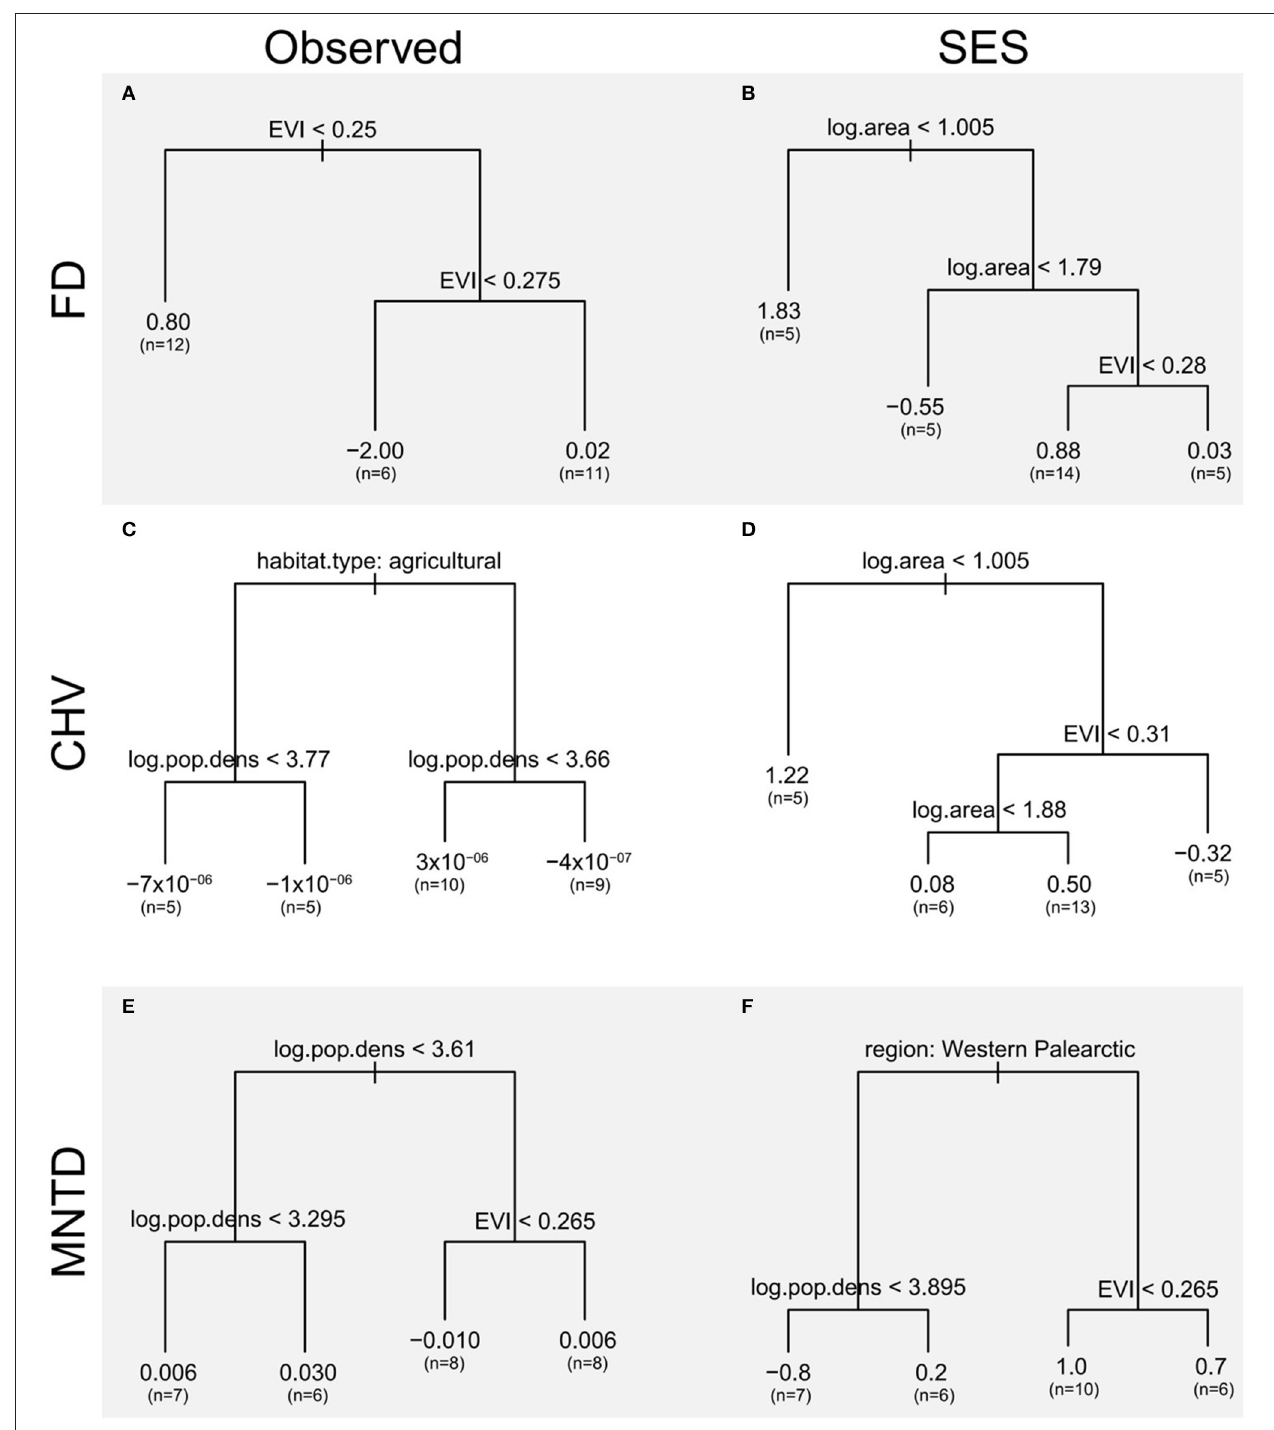
FIGURE 6 | Regression trees of differences in the functional diversity between urban and non-urban avian assemblages as a function of city traits EVI, a measure of the amount of vegetation, log area, log 10 of the spatial extent of the urban area (km 2 ) and log.pop.density, log 10 of the human population density (km − 2 ), nature of the non-urban assemblages (natural habitat or agricultural land) and bio-region. Regression trees are presented for (A,B) FD, (C,D) CHV, and (E,F) MNTD functional diversity metrics using observed values and standardized effect size metrics (SES) that take species richness into account. The left-hand branch of each tree is followed when the condition stated at the top of the branch is met. The length of each branch is proportional to the deviance explained by each split, the values at the end of each branch are the group mean and (in parentheses) the number of observations contributing to each branch.